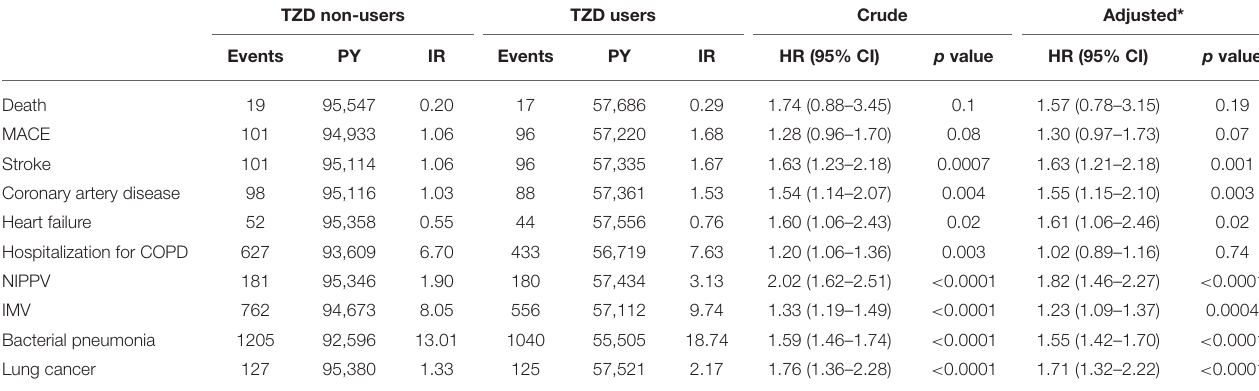
TABLE 2 | Outcomes of thiazolidinedione users and non-users. TZD non-users TZD users Crude